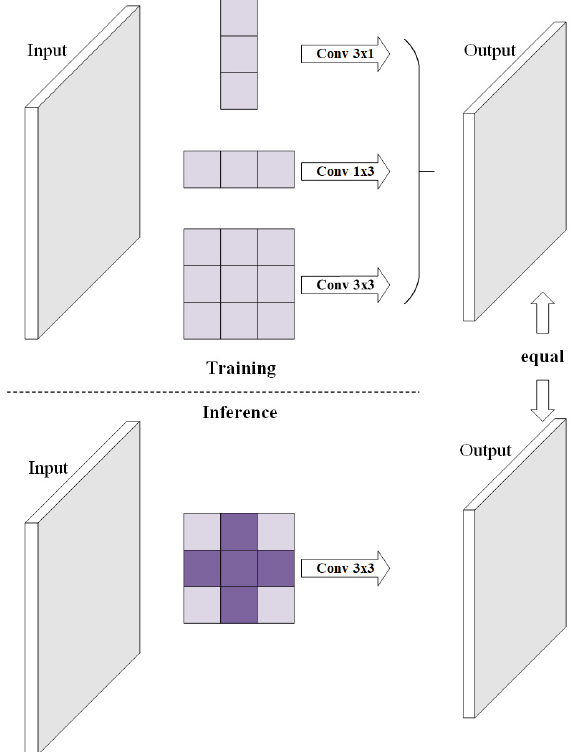
Figure 2. Asymmetric